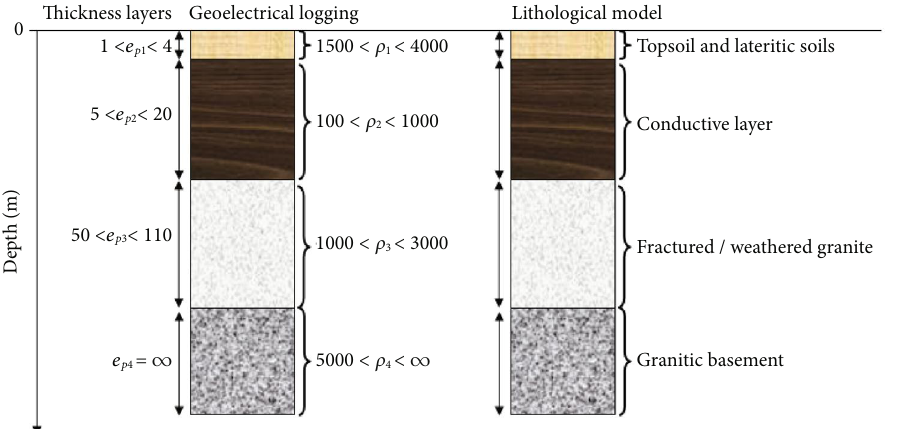
Figure 25: Lithological model of the sounding curves of type